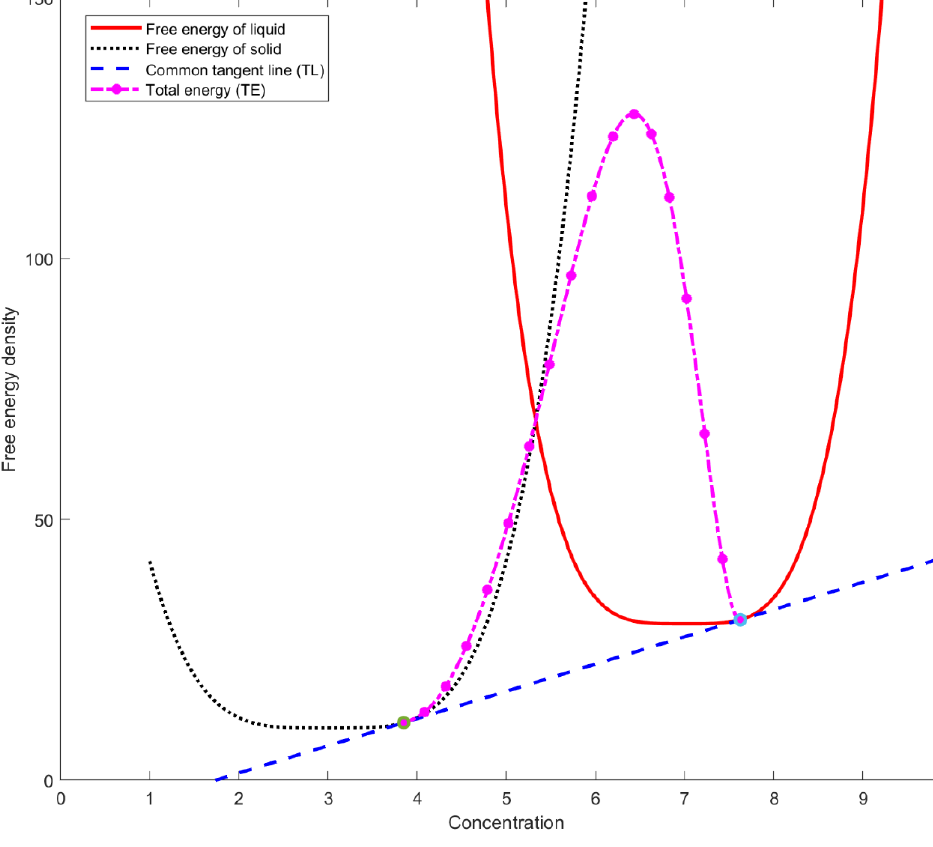
Figure 1. Free energy densities of solid and liquid vs. composition.